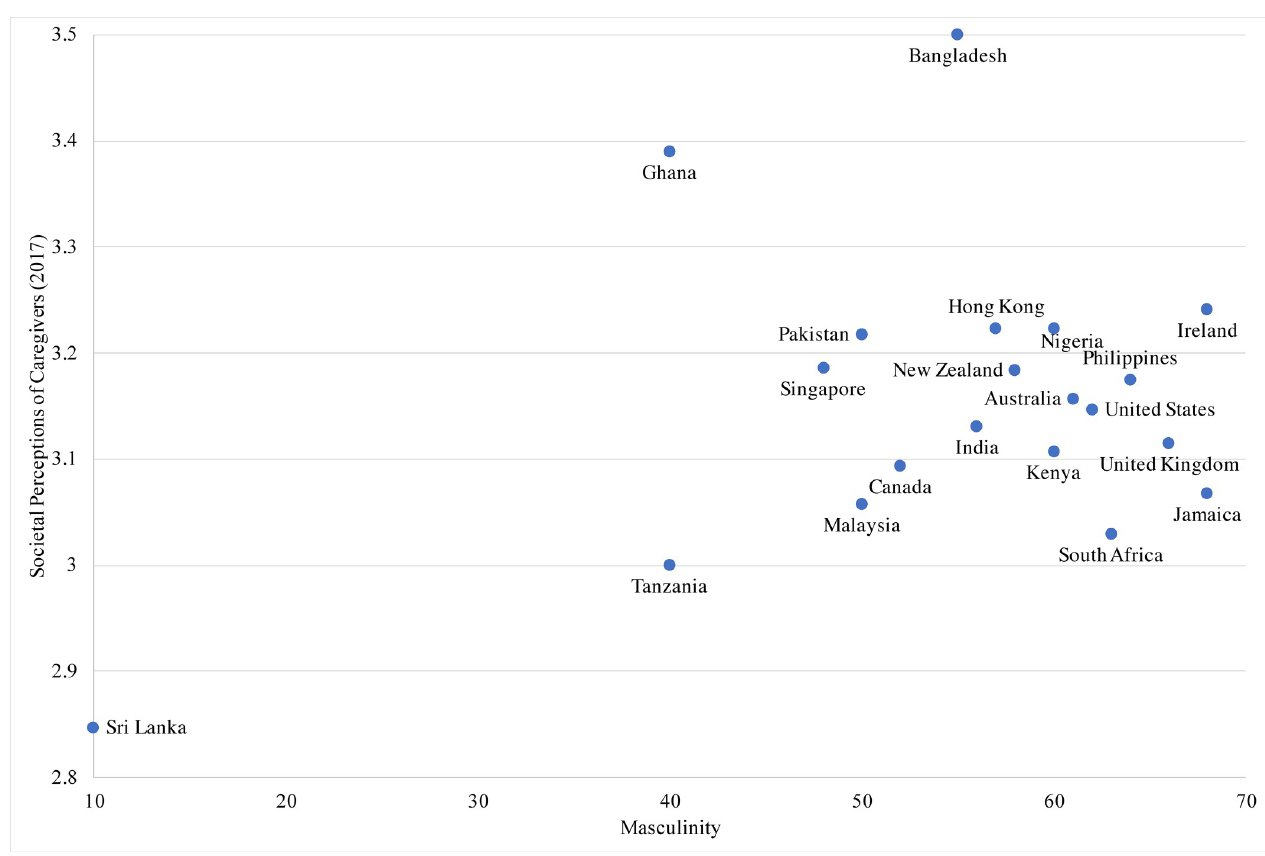
Fig 1. Scatterplot of societal perceptions of caregiving and masculinity across 20 countries.